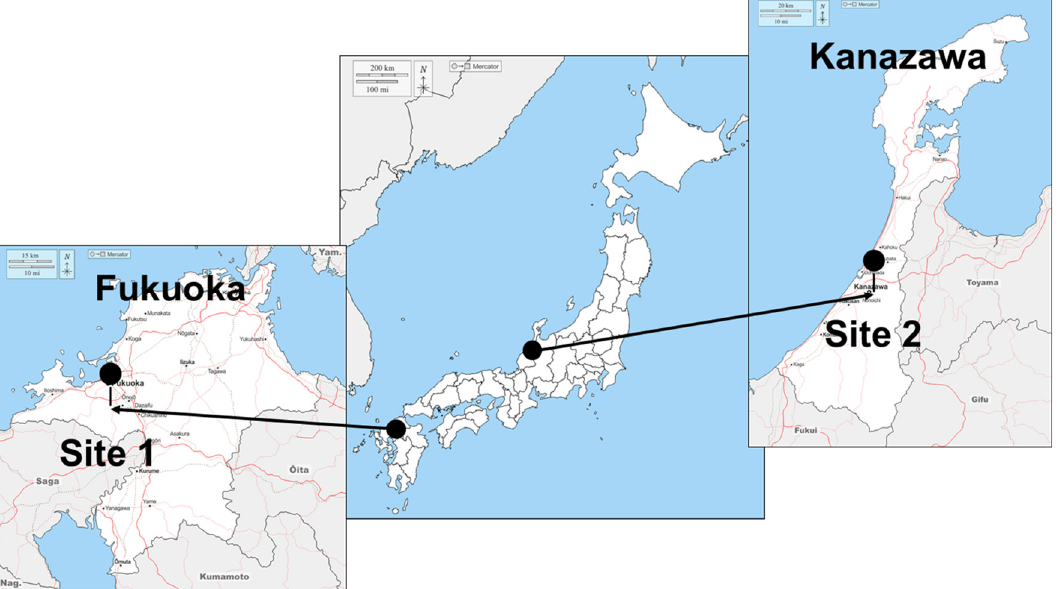
Figure 1. Map of sampling sites. Site 1: Fukuoka National Hospital (33.53° N, 130.41° E). Site 2: Kanazawa University (36.55° N, 136.67° E).